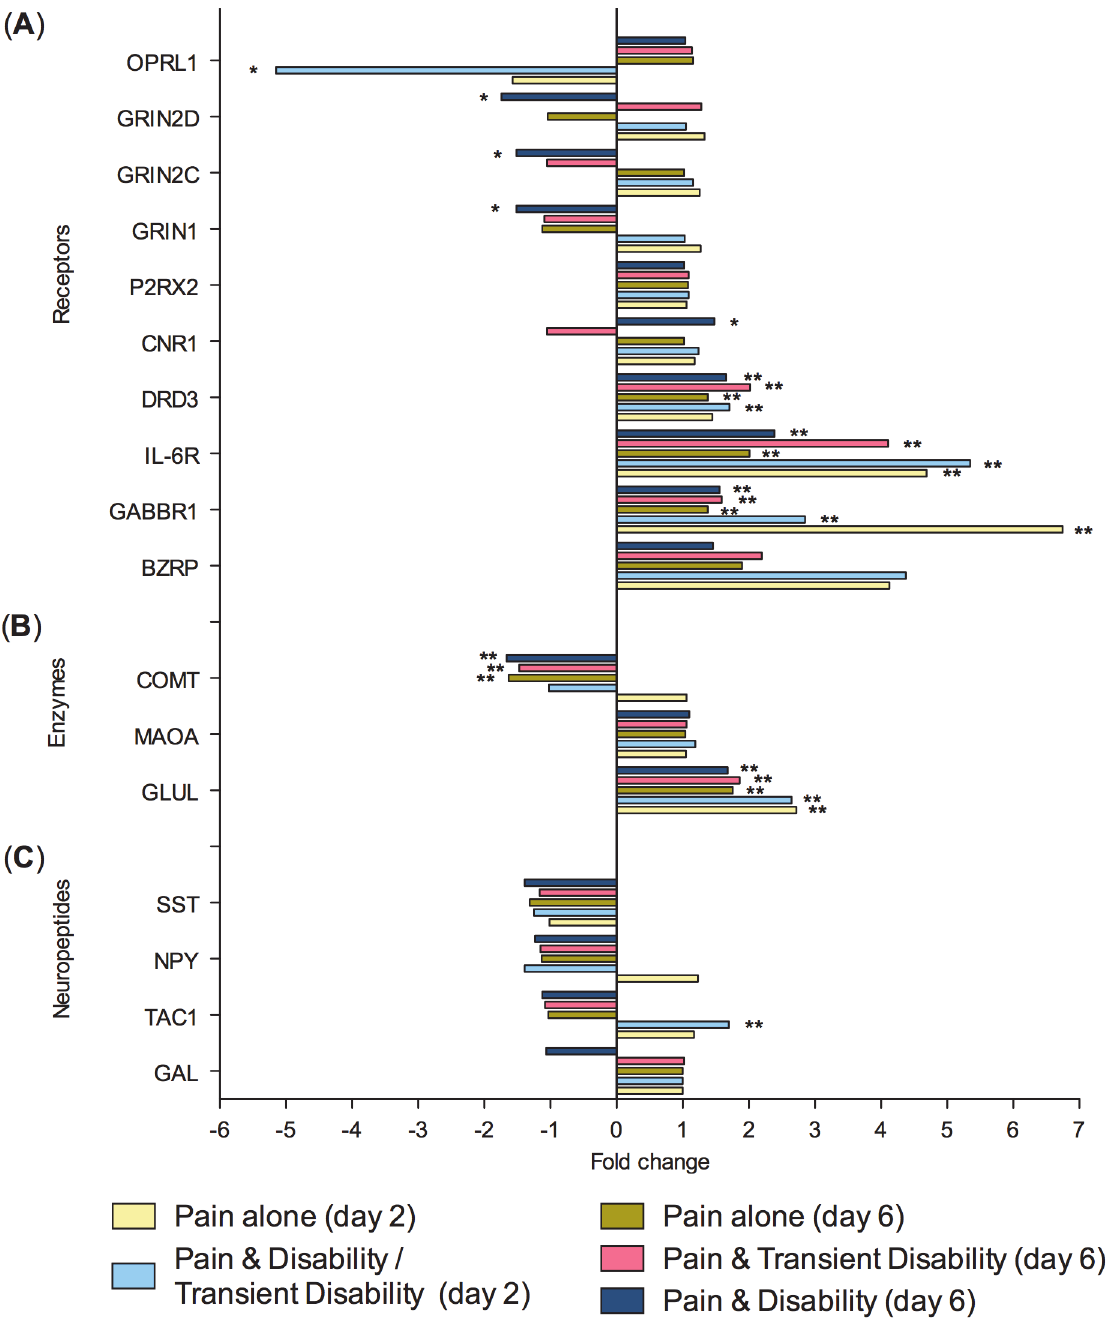
Fig 8. Gene transcripts that are significantly regulated in the lumbar spinal cord after CCI, as determined by real time PCR. Changes in gene expression have been tested at both 2 and 6 days after CCI on pooled mRNA samples from each disability group, compared to uninjured controls. Genes encoding; (A) receptors; (B) neurotransmitter degradation enzymes; and (C) neuropeptides. Statistically significant changes indicated by; * P < 0.05 and ** P < 0.005 (Pairwise Fixed Reallocation Randomisation Contest).